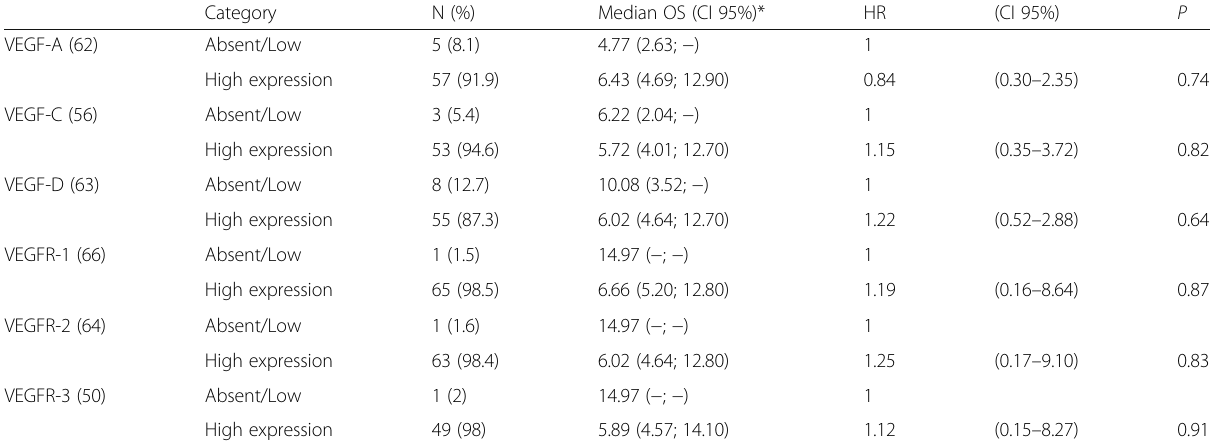
Table 5 Univariate model for analysis of the immunohistochemical expression according a binary category (absent/low vs high expression) for each VEGF subunit and receptors in GBMs